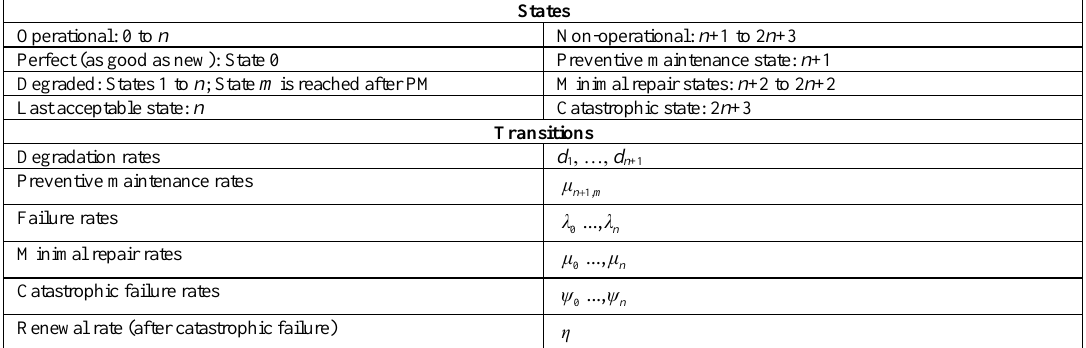
Figure 2. State-transition diagram for a multi-state degraded system subjected to condition-based preventive maintenance. Table 1. Notation used in figure